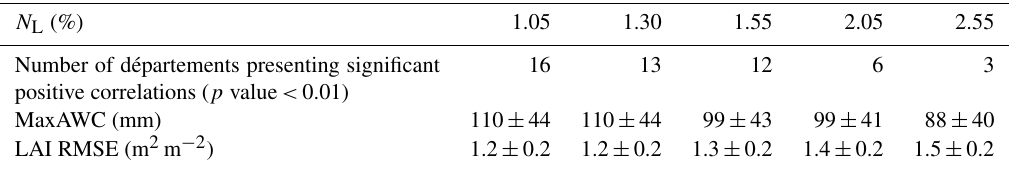
Table 2. Impact of N L on MaxAWC retrieval using a single-parameter inverse modelling technique. The retrieved median MaxAWC and LAI RMSE are given for all 45 départements together with their standard deviation. N L (%) Number of départements presenting significant positive correlations ( p value <